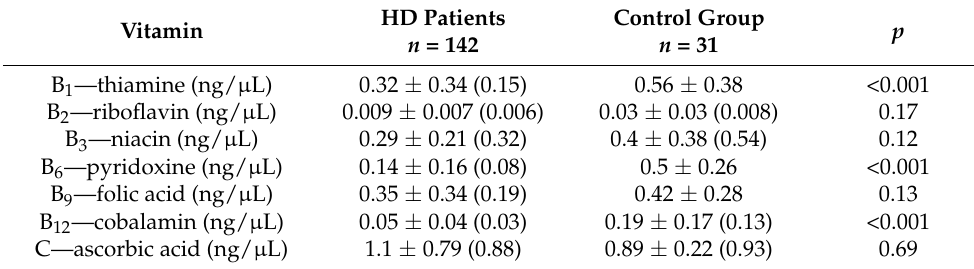
Table 3. Comparison of blood vitamin levels between HD patients and the control group.